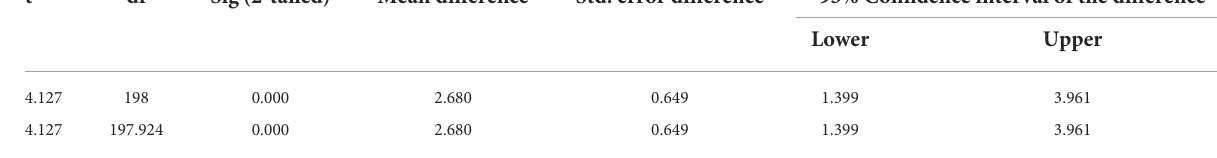
TABLE 2 T -test for the equality of